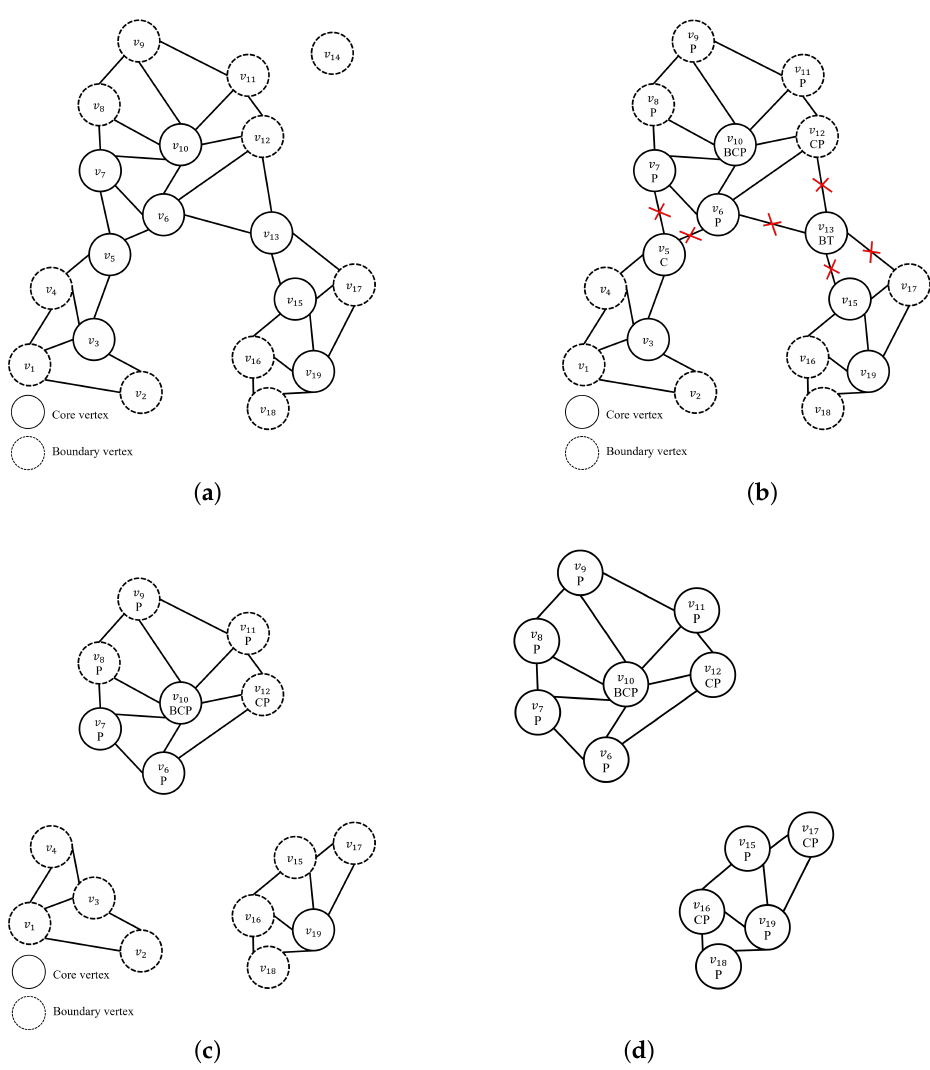
Figure 5. An example of DeepDBSCAN. ( a ) after constructNNGGraph ( k = 5); ( b ) after deepSelection , while traversing core vertices with the largest number of neighbors; ( c ) adjusted number of neighbors when neighbor vertexes or core vertexes dropped; ( d ) after density